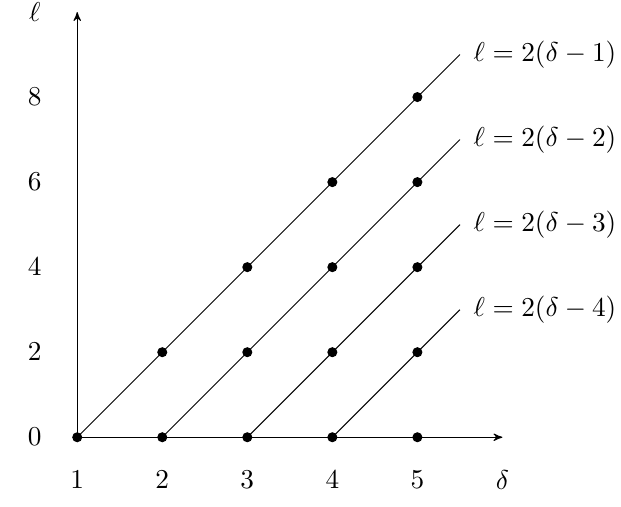
Figure 1 . Chew-Frautschi plot of the stringy